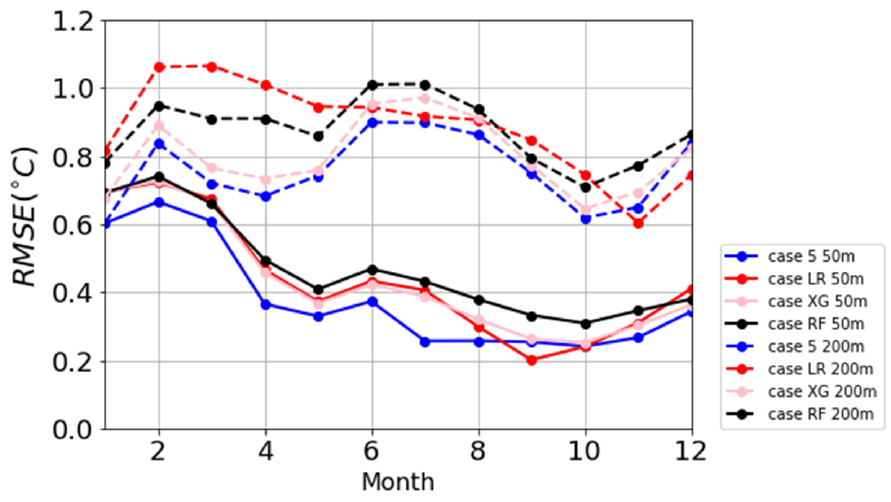
Figure 5. The average RMSE of the OST estimated by four different models for four seasons at 26 depth levels in 2016.